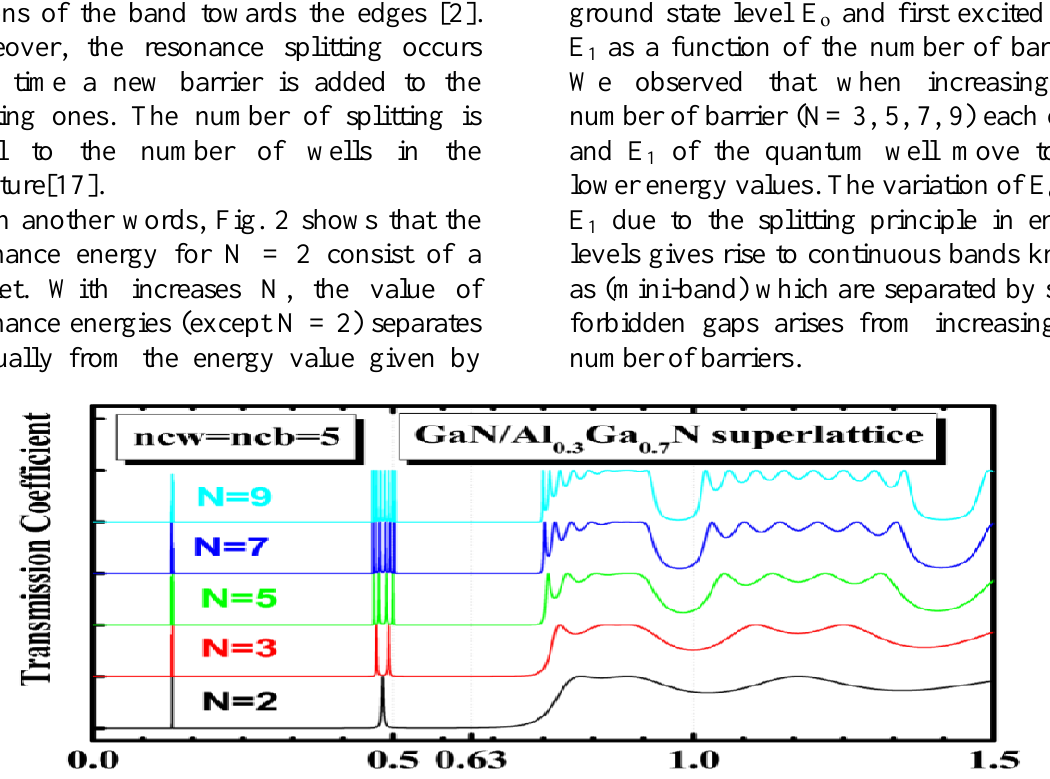
Ga N superlattice 0.3 0.7